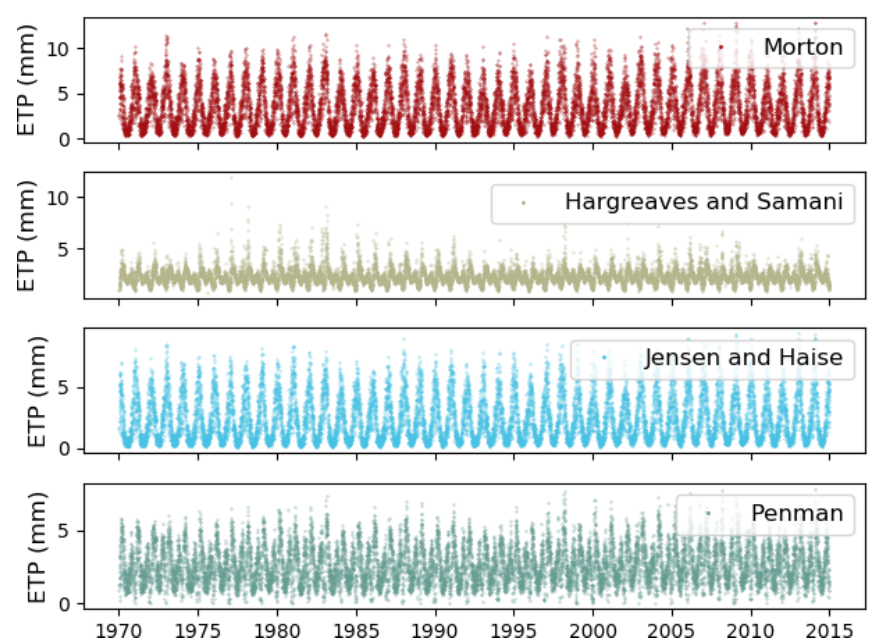
Figure 8. Comparison of various evapotranspiration methods for the CAMELS_AUS dataset. The CAMELS_AUS dataset comes with the Morton method, while the remaining three methods are calculated by the “et” sub-module of AI4Water.